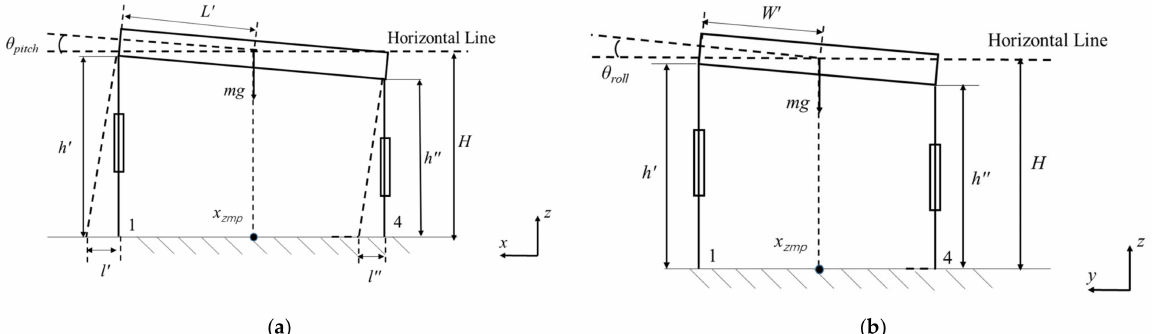
Figure 5. The robot attitude feedback is displayed from different perspectives. In ( a ), it’s a view from the positive to the negative direction of the y axis. In ( b ), it’s a view from the positive to the negative direction of the x